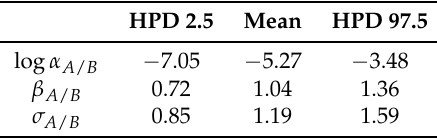
Table 4. Posterior distribution of parameter